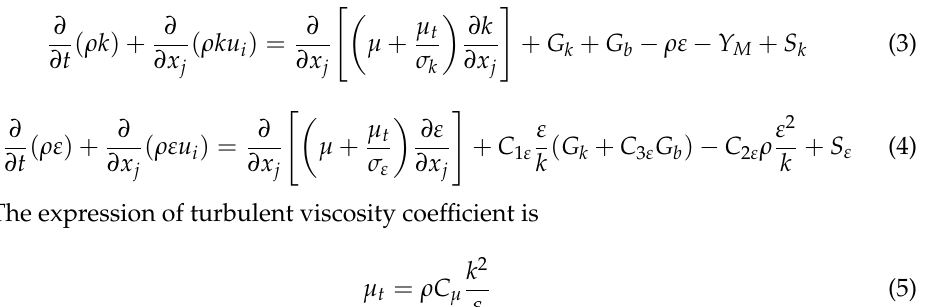
Figure 2. Schematic diagram vortex model.